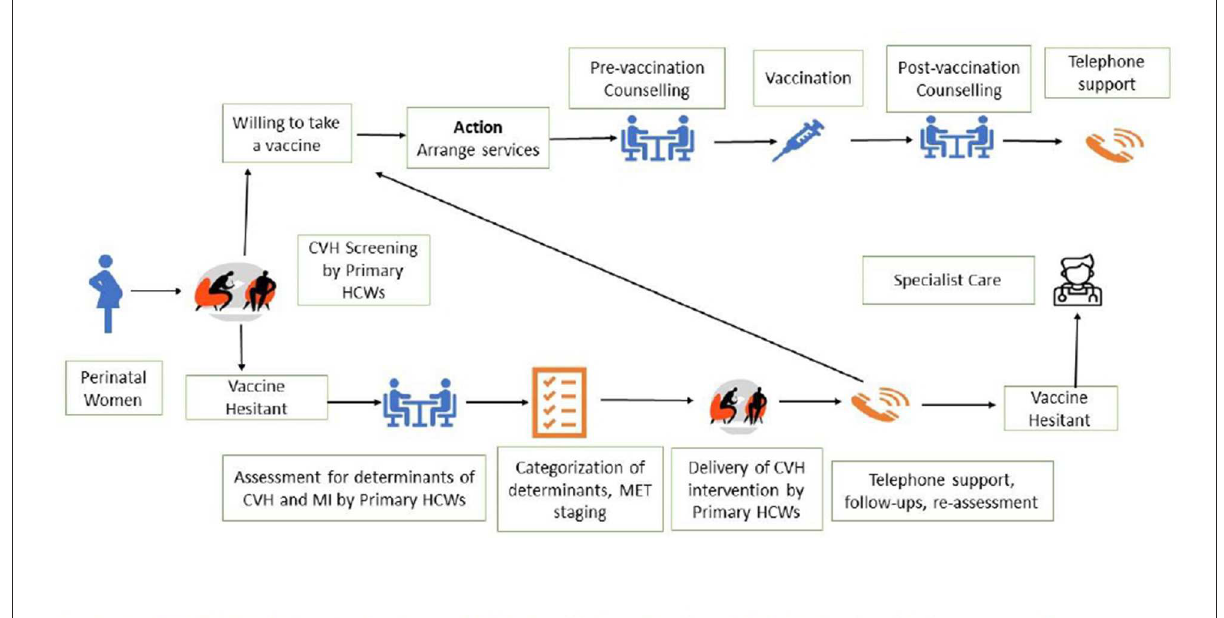
FIGURE2 Algorithm for CVH screening and